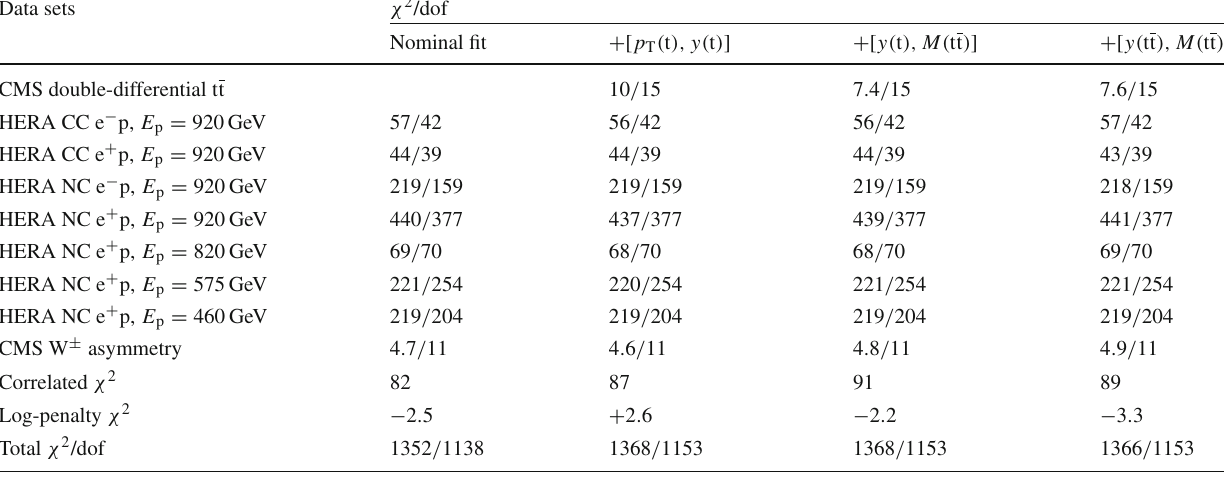
Fig. 14 The gluon ( upper left ), sea quark ( upper right ), u valence quark ( lower left ), and d valence quark ( lower right ) = 30 , 000GeV 2 , as PDFs at μ 2 f obtained in all variants of the PDF fit, normalized to the results from the fit using the HERA DIS and CMS W ± boson charge asymmetry measurements only. The shaded , hatched , and dotted areas represent the total uncertainty in each of the